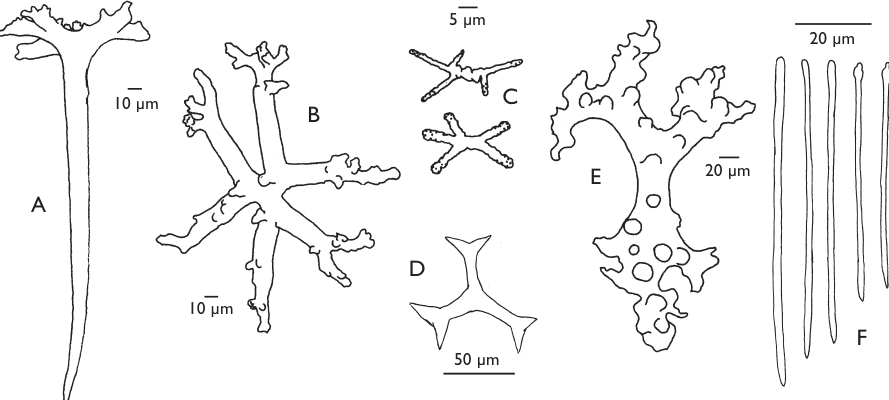
Fig. 3. Neophrissospongia nana nov. sp., holotype MSNG 54599, spicular complement. A. Dichotriaene. B. Cladome of a tubercled dichotriaene (top view). C. Streptaster/amphiaster microscleres with tubercles. D. Cladome of a smooth dichotriaene (top view). E. Dicranoclone desma. F.